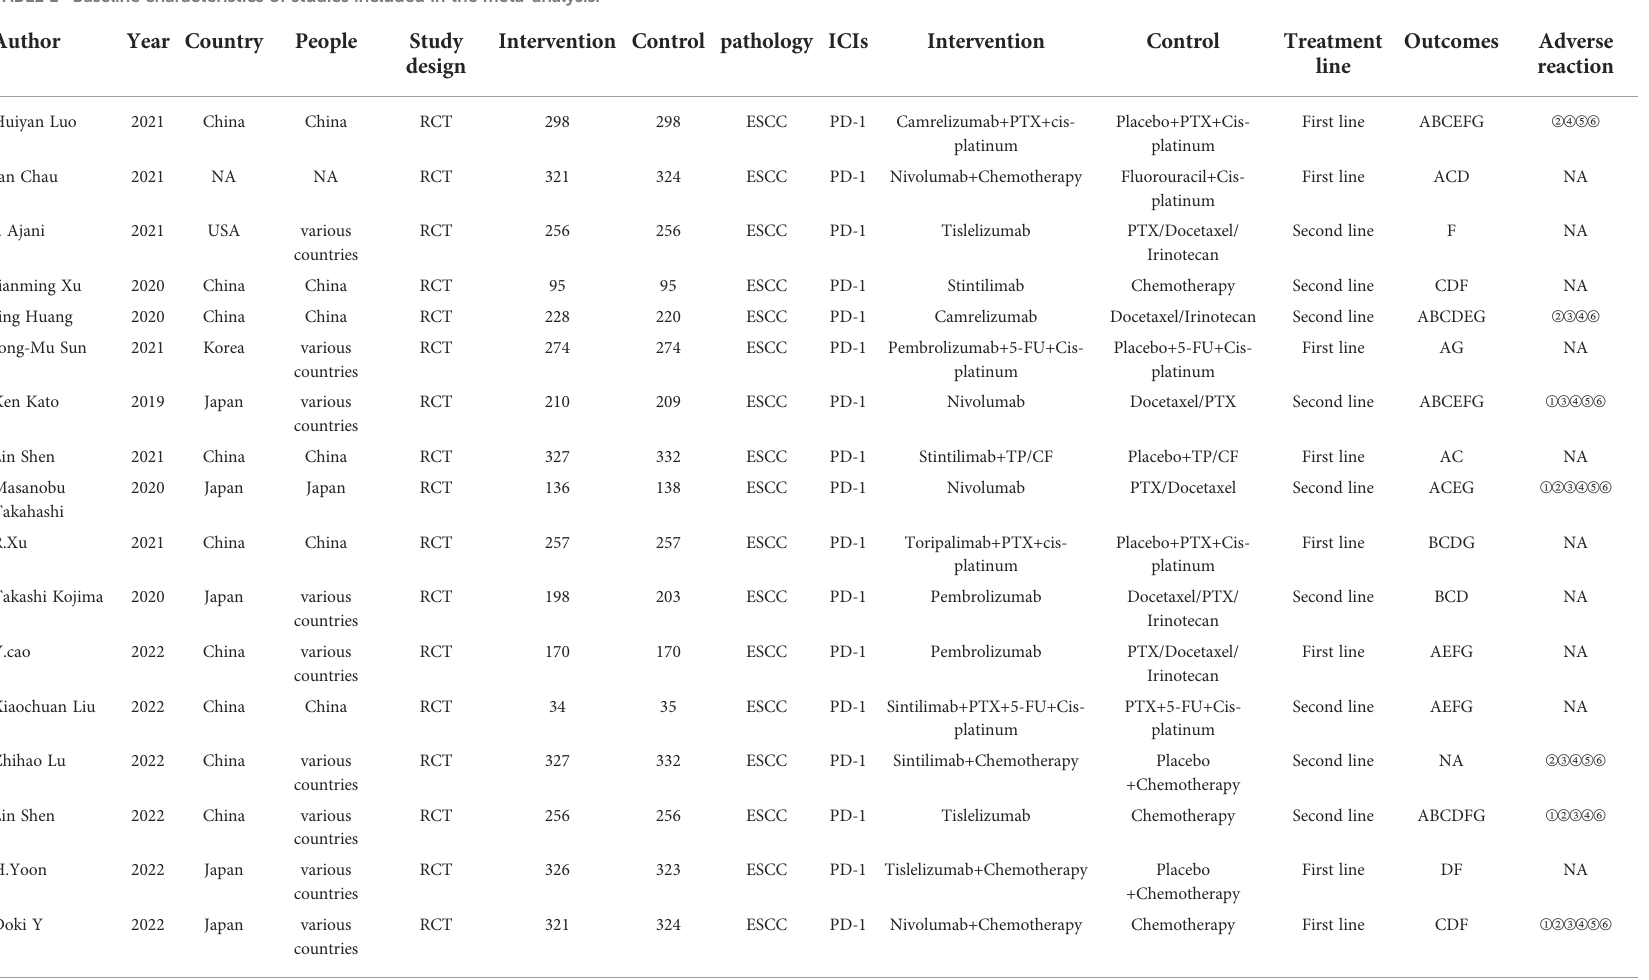
TABLE 1 Baseline characteristics of studies included in the